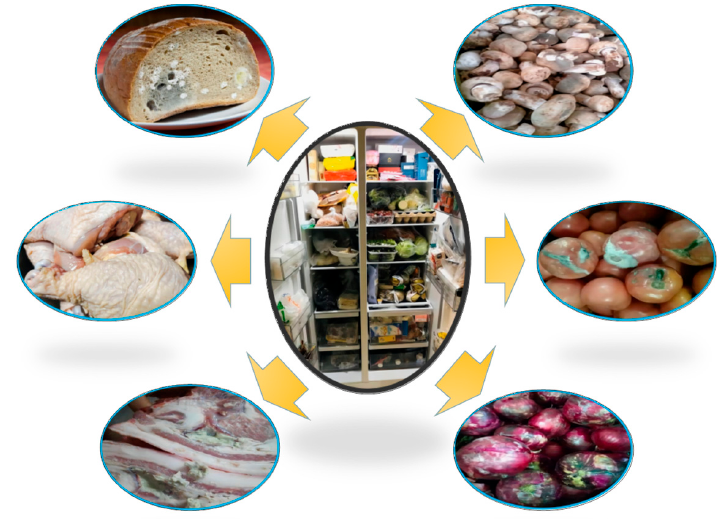
Figure 1. Food waste caused by IFHB.